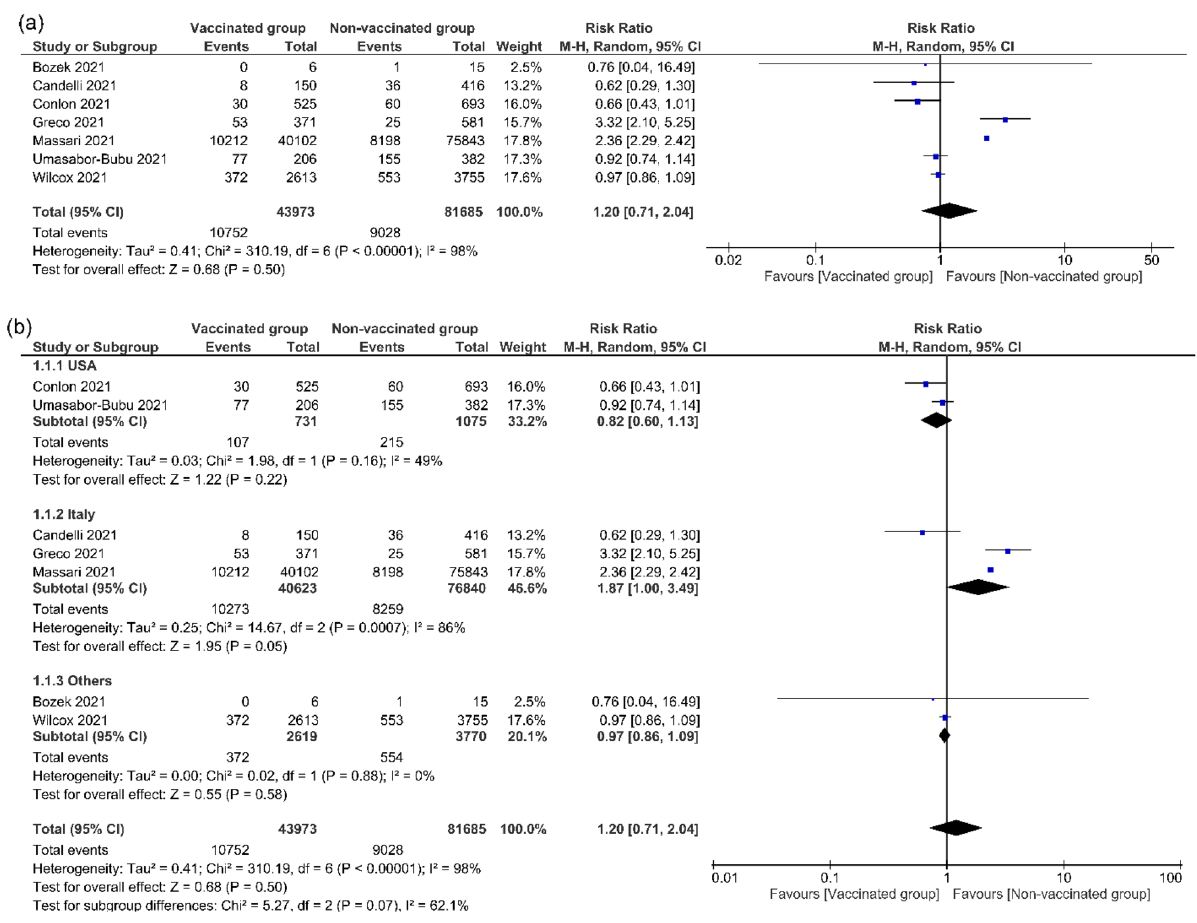
Figure 2. Mortality rate. This figure shows the forest plot of ( a ) Mortality rate between influenza vaccinated group and non-vaccinated group, ( b ) Subgroups of mortality rate according to countries USA, Italian, and other